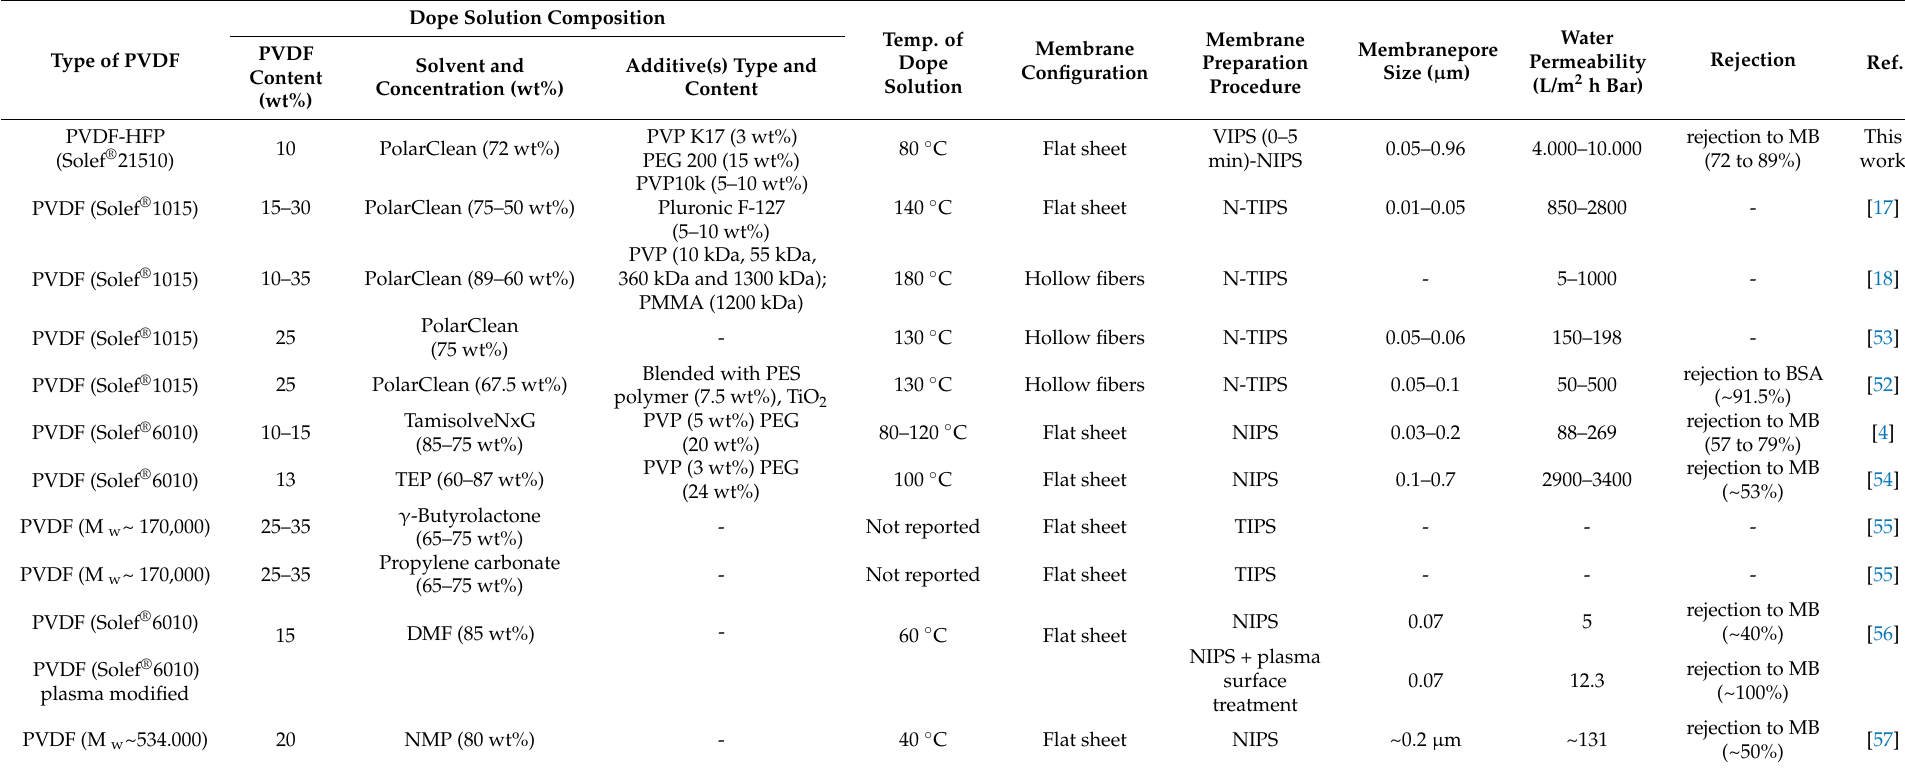
Table 7. Dope composition, preparation procedure and performance of PVDF-based membranes prepared using PolarClean and other green and traditional solvents.